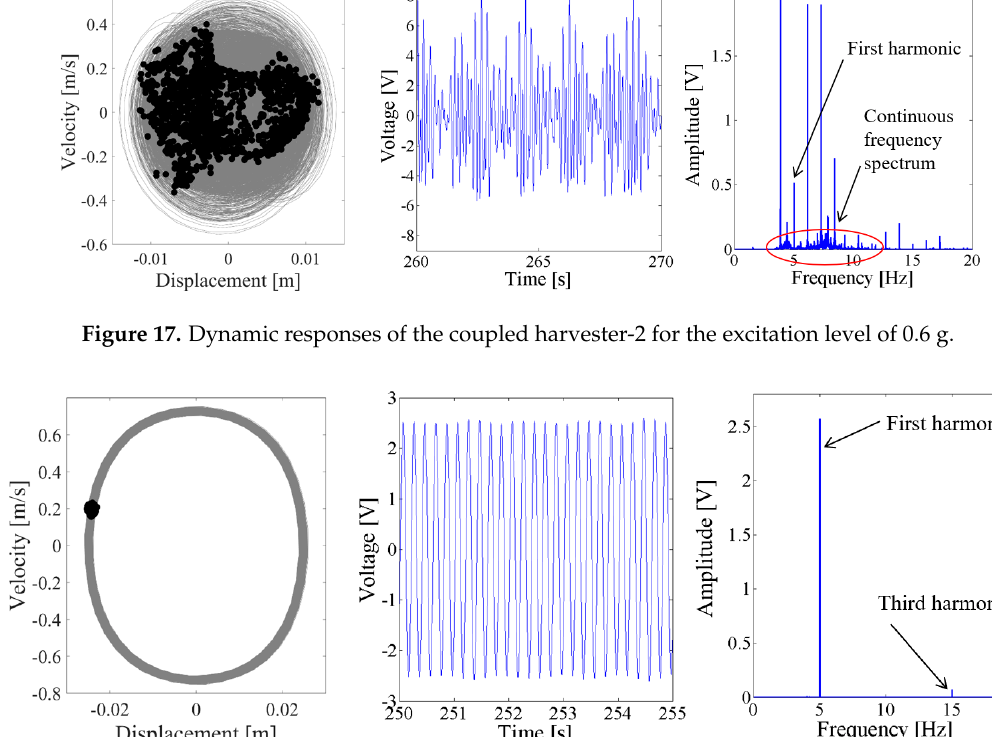
Figure 19. Dynamic responses of the coupled harvester-2 for the excitation level of 0.9 g. Above analysis demonstrates that the nonlinear dynamic response characteristics of the NPEHS change along with the excitation conditions, and its response may be periodic or chaotic depending on the excitation conditions and initial conditions. Meanwhile, the fundamental harmonic is an important component in the response voltage and the response displacement, and there are sub-harmonics and super-harmonics under some excitation conditions. These features can be used to enhance energy harvesting and sensing in the further study.